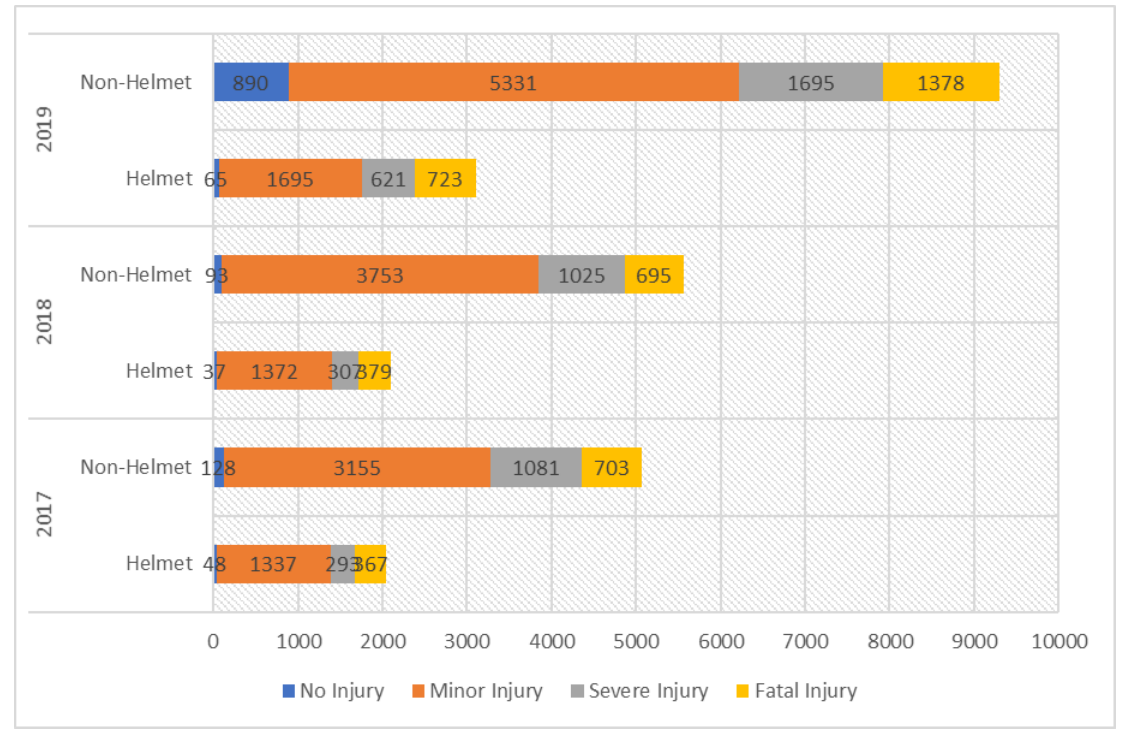
Figure 1. Motorcyclist’s injury severity for helmet and non-helmet motorcycle crashes over the years: 2017–2019. Table 2. Descriptive statistics of significant variables in the helmet-wearing and non-helmet-wearing motorcyclists’ injury severity